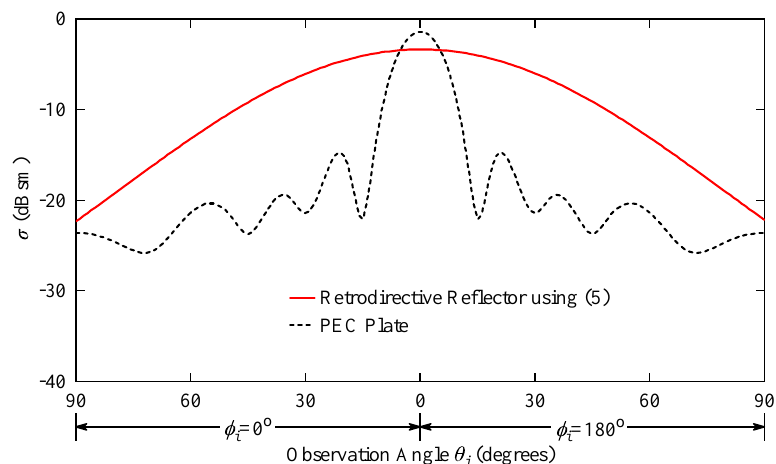
Figure 15. Comparison of the ideal monostatic RCS between a retrodirective reflector ( σ R ) obtained by using (5) and a flat PEC.